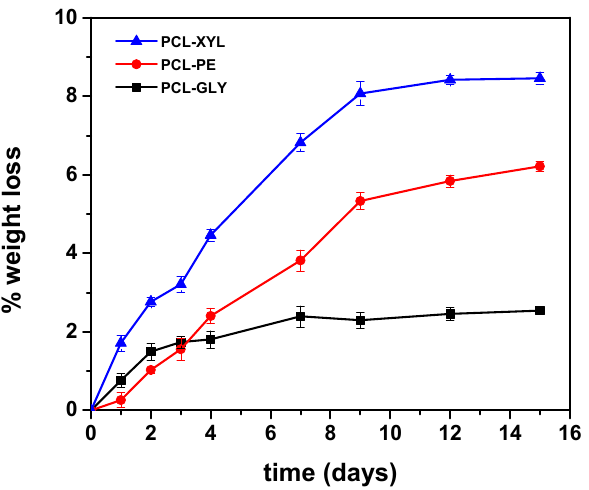
Figure 5. Hydrolysis rate (measured as % weight loss) of the synthesized PCL-based copolymers in the presence of Rhizopus delemar and Pseudomonas cepacia lipases.